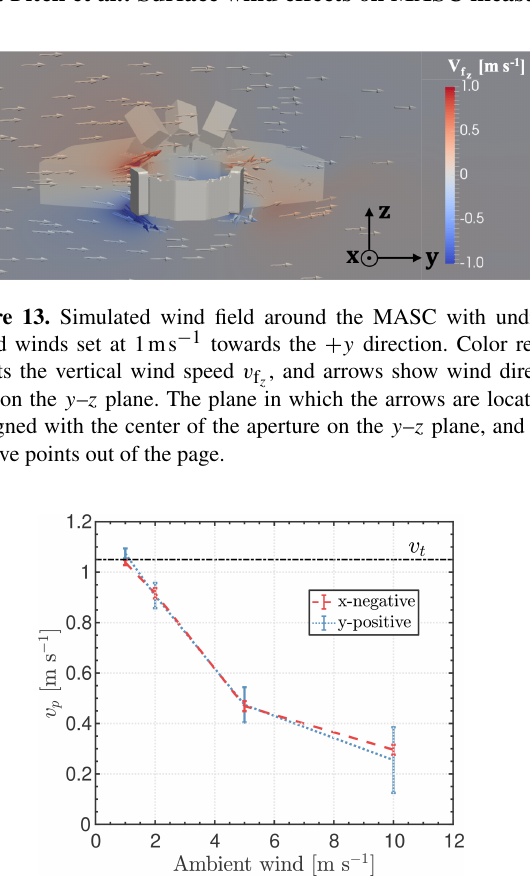
Figure 15. Mean fall speed v p of particles versus ambient wind speed for different values of initial TKE. Terminal fall speed v t is included for comparison. Data are sampled at the center of the aper-